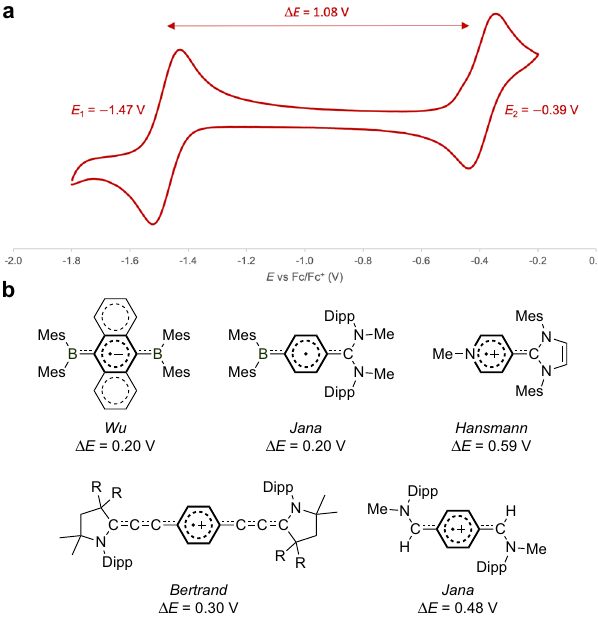
Fig. 2 Syntheses and characterization of neutral organoboron analogues of Thiele ’ s hydrocarbon. a Syntheses of 1 and 2 . b Solid-state structure of 2 with side view. For clarity, H atoms are omitted, and Dipp/Mes groups are simpli fi ed as wireframes. Thermal ellipsoids set at 50% probability. Key distances (Å): B1 − N1 1.424(4), C1 − C2 1.356(4), N1 − C3 1.415(4), N1 − C4